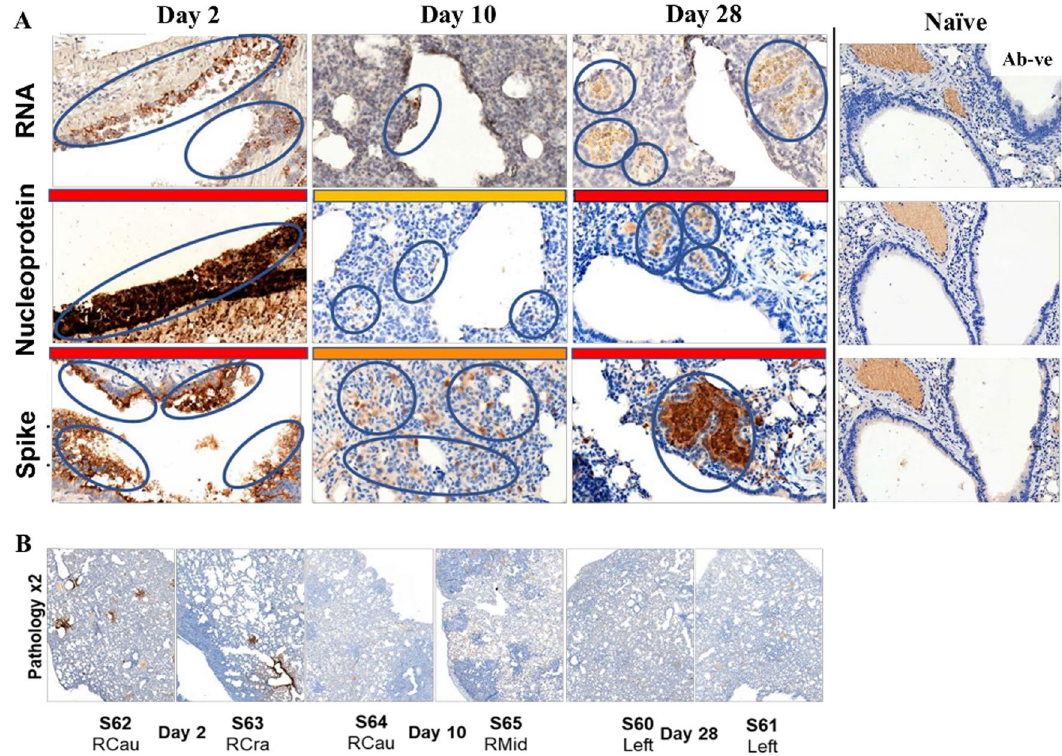
Figure 4. Detection and localisation of SARS-CoV-2 and sub-gross histopathological lesions in lung tissue. ( A ) RNAscope, nucleoprotein and spike protein detection in hamster lung sections across the 2, 10 and 28 day time- course. ( B ) sub-gross pathologic analysis of lung sections at each time point indicated. Brown labelling indicates nucleoprotein in lesions taken as a focus of infection of SARS-CoV-2. Day 2, RCau (right caudal), RCra (right cranial); day 10 RCau (right caudal), RMid (right middle). Labelling intensity indicated by red bars (high), orange bars (intermediate) and yellow bars (low) for IHC